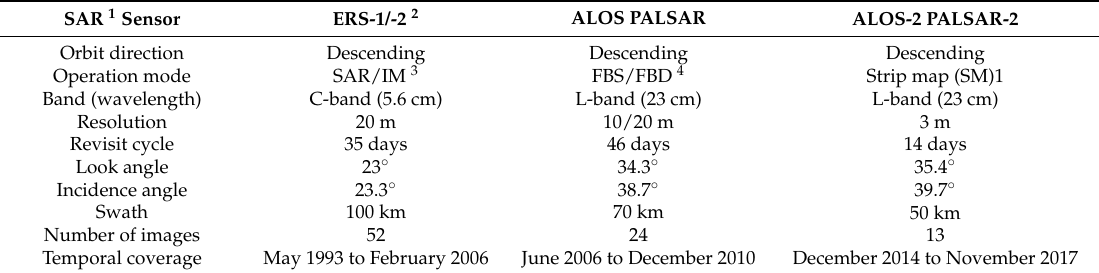
Table 2. Acquisition parameters of the ERS-1/-2, ALOS PALSAR and ALOS-2 PALSAR-2 data sets. SAR 1 Sensor ERS-1/-2 2 ALOS PALSAR ALOS-2 PALSAR-2 Orbit direction Descending Descending Descending Operation mode SAR/IM 3 FBS/FBD 4 Strip map (SM)1 Band (wavelength) C-band (5.6 cm) L-band (23 cm) 23 ◦ Incidence angle 23.3 ◦ 38.7 ◦ Swath 100 km